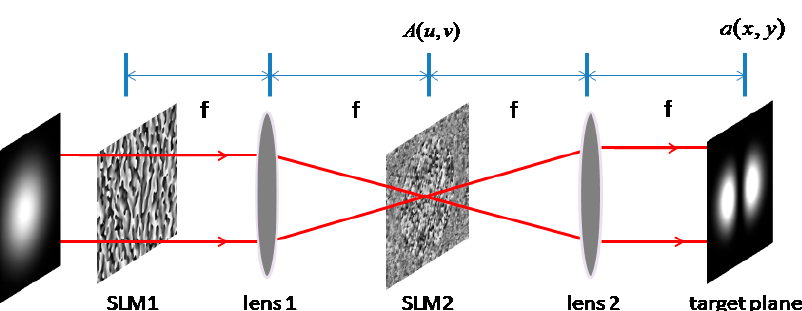
Figure 1. Principle of the cascaded SLM system. The complex amplitude field in the target plane is generated by cascade SLMs, which are placed in the conjugate plane of lens1.